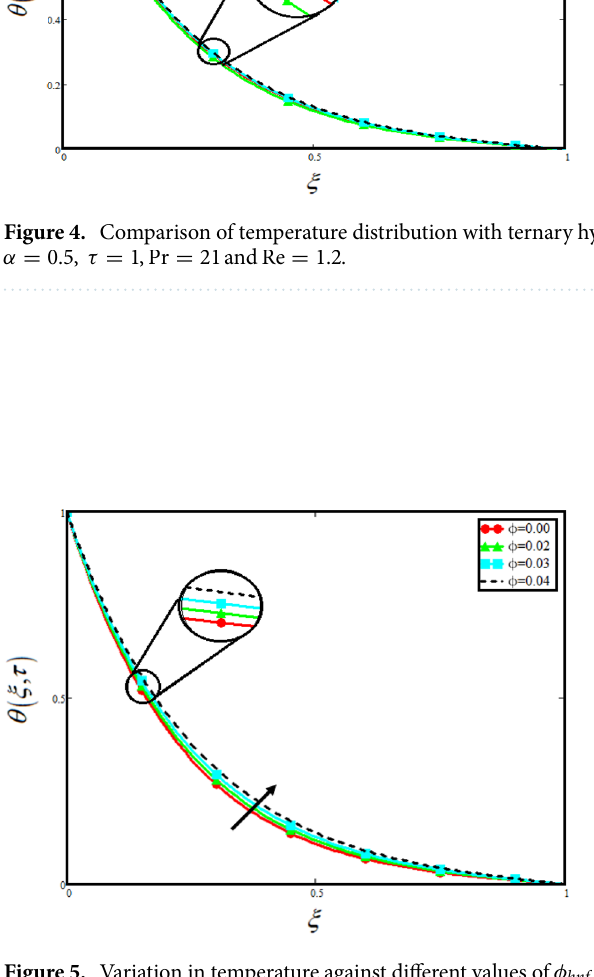
Figure 5. Variation in temperature against different values of φ hnf when τ = 1 , α = 0.5 , Pr = 21 and Re = 1.2